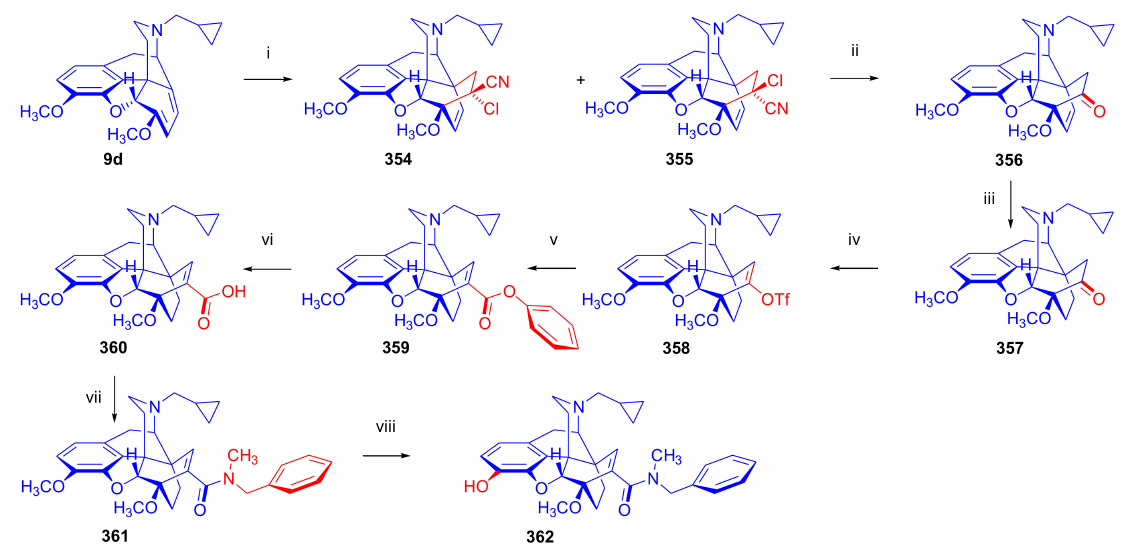
Figure 91. Synthesis of ∆ 7,8 -7-carboxamido-6,14-ethenomorphinan derivatives. Reagents and con- ditions : (i): 2-chloroacrylonitrile, aromatic hydrocarbon, microwave irradiation, 180 ◦ C, 10 bar, 30 min; (ii): 1M NaOH (aq), EtOH, 44%; (iii): H 2 , 5% Pd-C, EtOH, 60 ◦ C, 12 h, 92%; (iv): N -phenyl- bis(trifluoromethanesulfonamide), KHMDS, toluene, -78 ◦ C, 1 h, 99%; (v): 2,4,6-trichlorophenyl formate, palladium acetate, Xantphos, Et 3 N, 90%; (vi): (A) 1M NaOH (aq), THF, 60 ◦ C, 7 h, or (B) 6M NaOH, 60 ◦ C, 3 h, 60%; (vii): benzylmethylamine, THF, Et 3 N, DMAP, 50 ◦ C, 3.5 h, 86%; and (viii): BBr 3 , CH 2 Cl 2 , room temperature, 1.5 h,